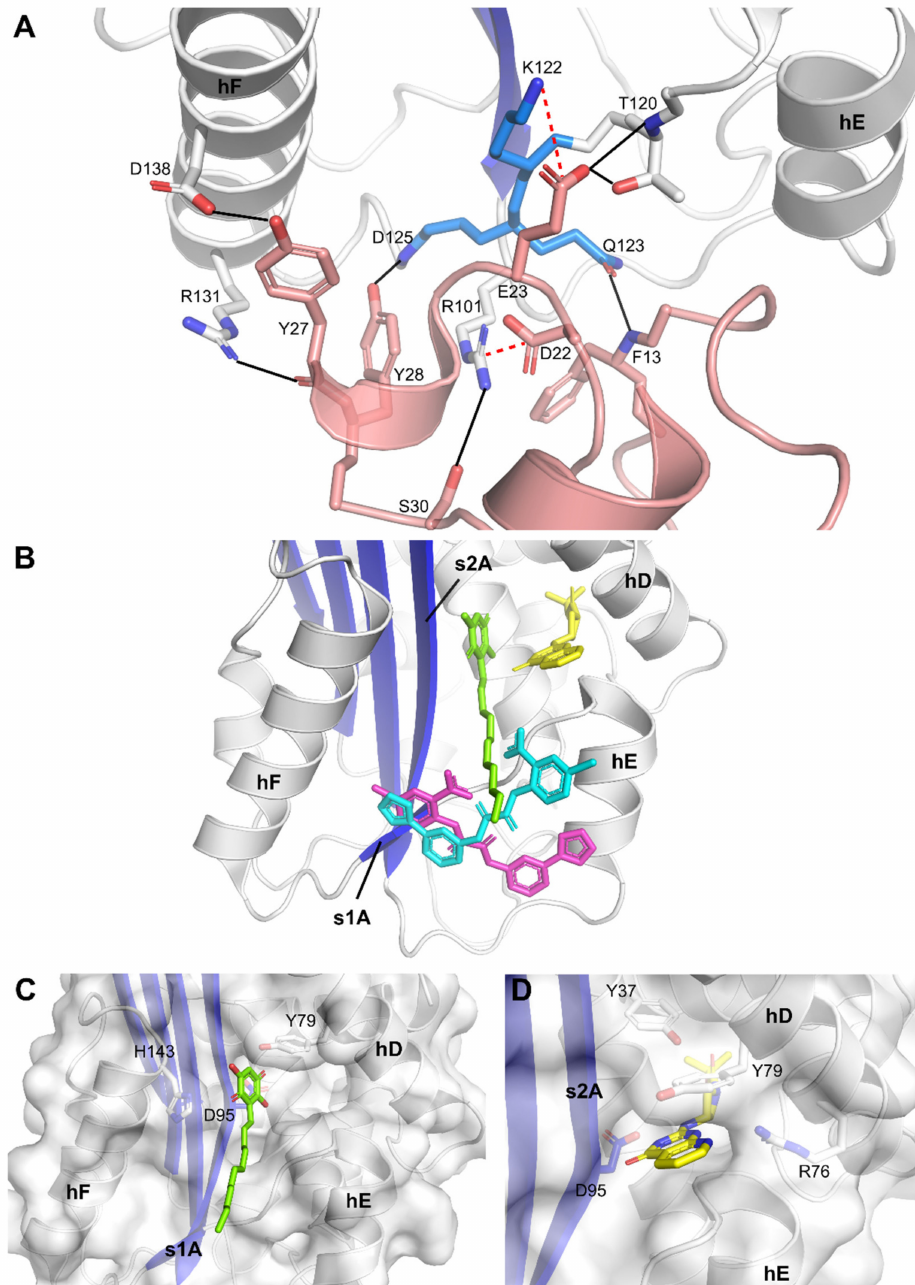
Figure 5. X-ray crystallographic structures of PAI-1 bound to vitronectin (Vn) and small molecule PAI-1 inhibitors. ( A ) Detail of the interaction between active PAI-1 and the somatomedin B (SMB) domain of Vn (pink, Protein Data Bank (PDB) ID: 1OC0 [8]). Hydrogen bonds are presented as black lines and salt bridges as dashed lines; ( B ) superimposition of the published crystal structures of PAI-1 in complex with embelin (green) and AZ3976 (yellow) with the structures of TM5484 bound to PAI-1/Nb42/Nb64 (magenta) and to PAI-1-stab (cyan); ( C ) cartoon representation of embelin (green) bound to a groove aligned by hD, hF, s2A and the hE-s1A loop in active PAI-1 (PDB ID: 3UT3 [38]); ( D ) cartoon representation of AZ3976 (yellow) bound to a deep pocket aligned by hD and s2A in latent PAI-1 (PDB ID: 4AQH [39]). PAI-1 is colored white with the central β -sheet A shown in